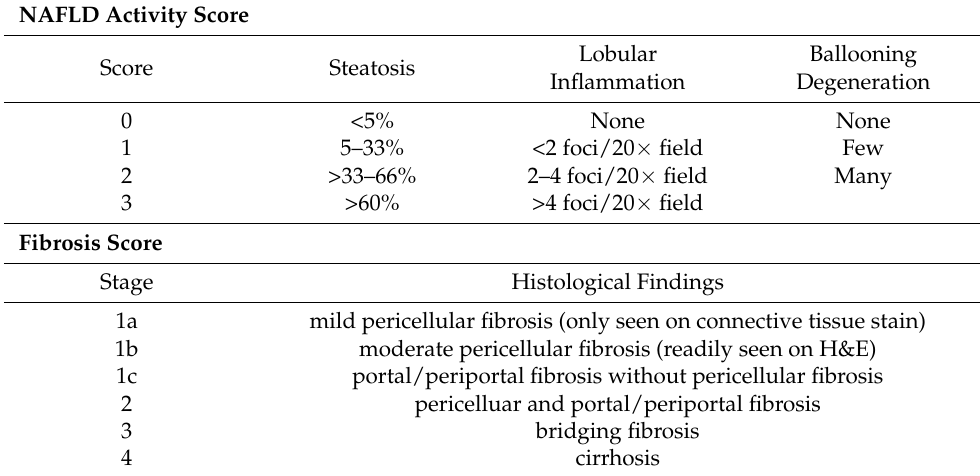
Table 1. NAFLD Activity Score (NAS) and Fibrosis Score. Adapted from [34].